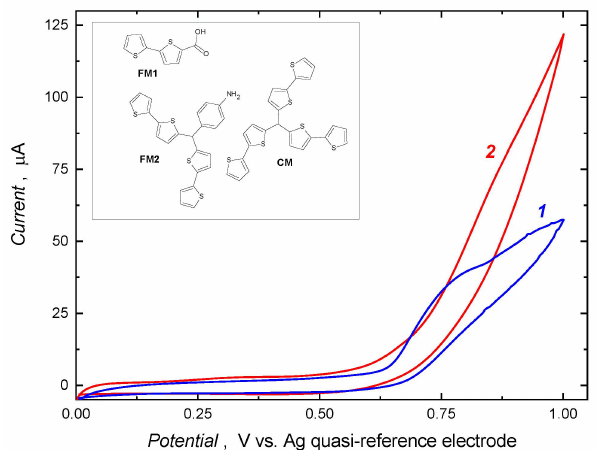
Figure 1. Current–potential curves of one-cycle potentiodynamic electropolymerization leading to deposition of the film of (1) MIP and (2) non-imprinted polymer (NIP) on the surface plasmon resonance (SPR) chip from a mixture of acetonitrile solutions of 1 µ L of 3 mg / mL, i.e., 0.045 mM, (functional monomer)-derivatized HSA, as well as 100 µ L of 1 µ M 5,5 (cid:48) ,5 (cid:48)(cid:48) -methanetriyltris(2,2 (cid:48)